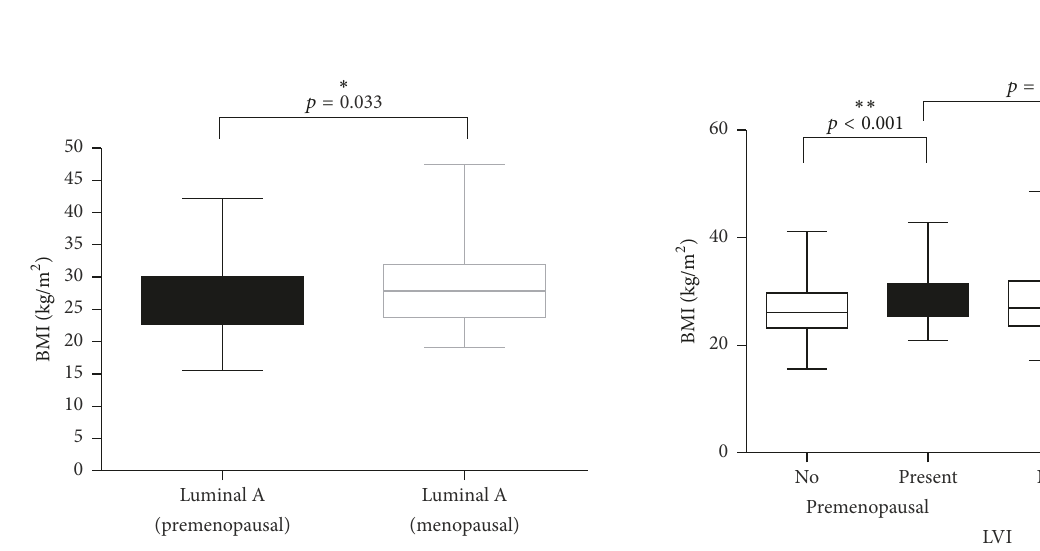
Figure 3: LVI is associated with higher BMI in premenopausal breast cancer patients. ∗∗ refers to the level of